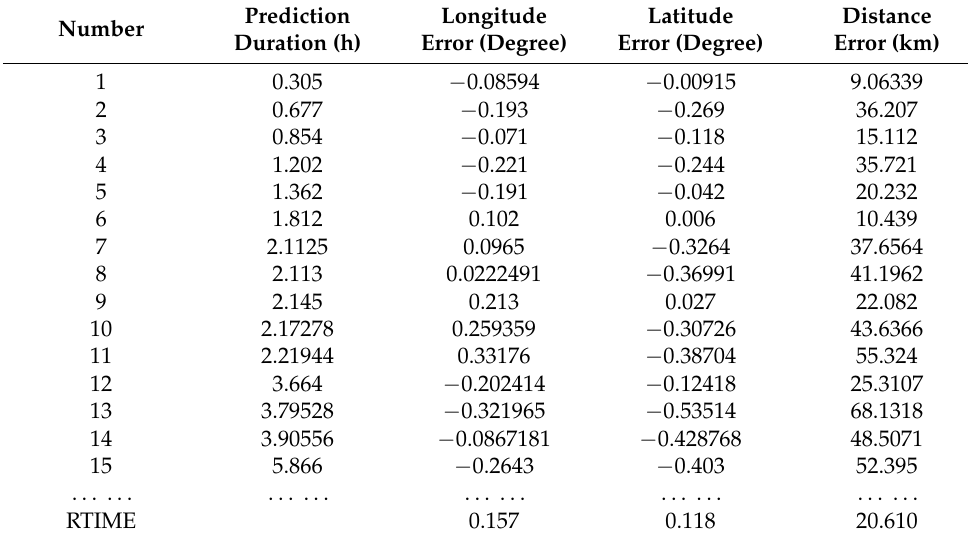
Table 2. The predicted results of the test